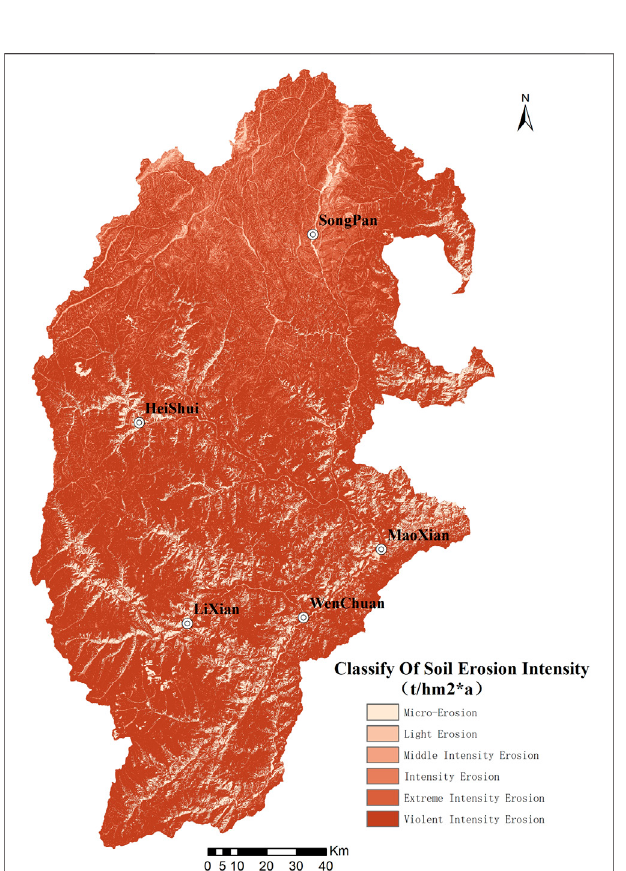
FIGURE8 | Gradingmap of soil erosion intensity in the upper reachesof the Minjiang river.